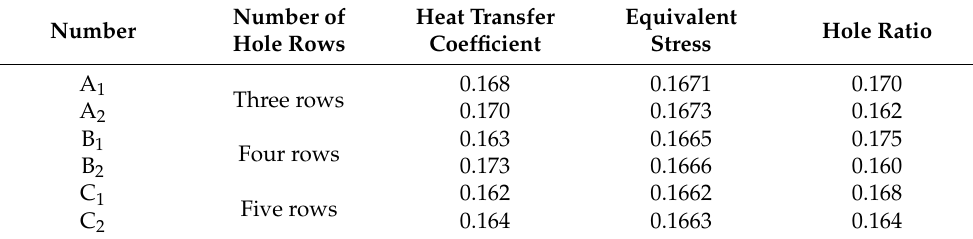
Table 7. Dimensionless calculation results of each influence factor.